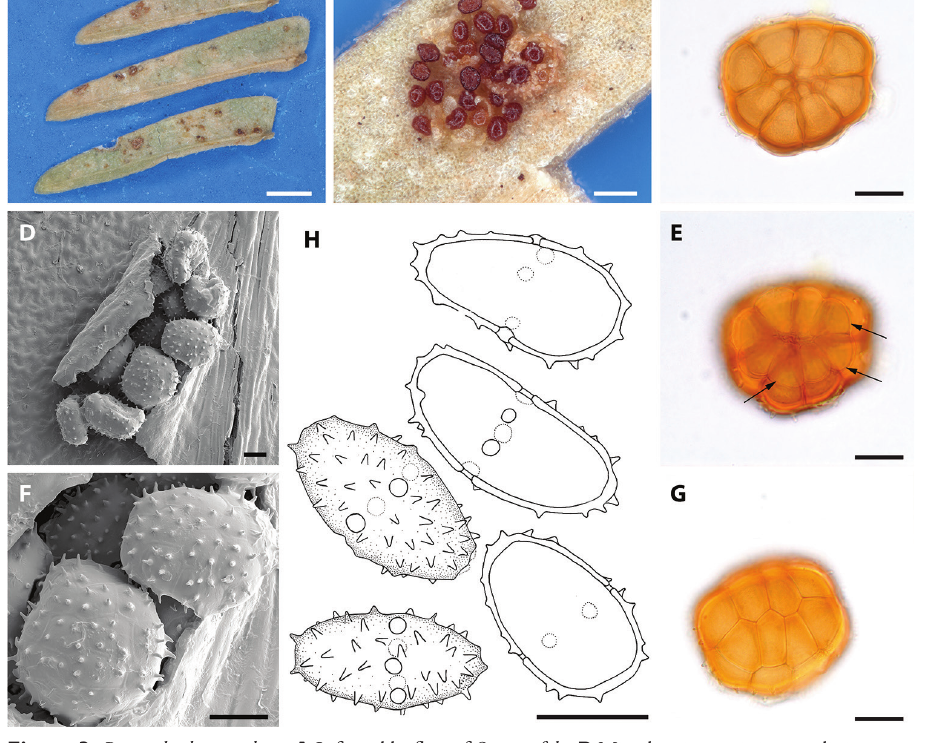
Figure 3. Ravenelia hernandezii . A Infected leaflets of S. tenuifolia B Mixed sori containing urediniospores and teliospores C Teliospore seen in LM D telium seen by SEM E Adaxial view of a teliospore by LM, with arrows indicating the uniseriate cysts F SEM view of spinescent teliospores G LM view of the upper surface H drawing of a urediniospore. Scale Bars: 0.5 mm ( A ); 0.1 mm ( B ); 20 mm ( C–G ); 10 mm ( H